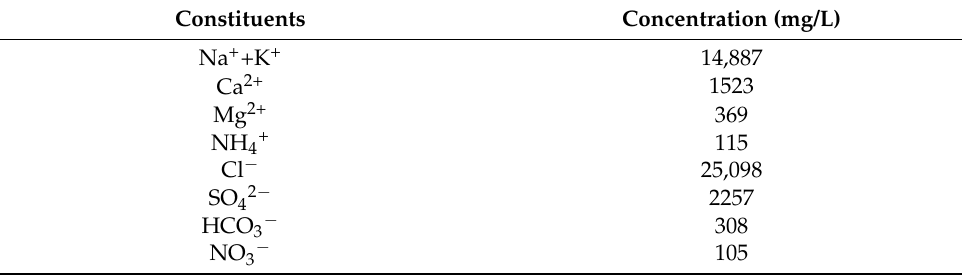
Table 1. Chemical composition of oilfield